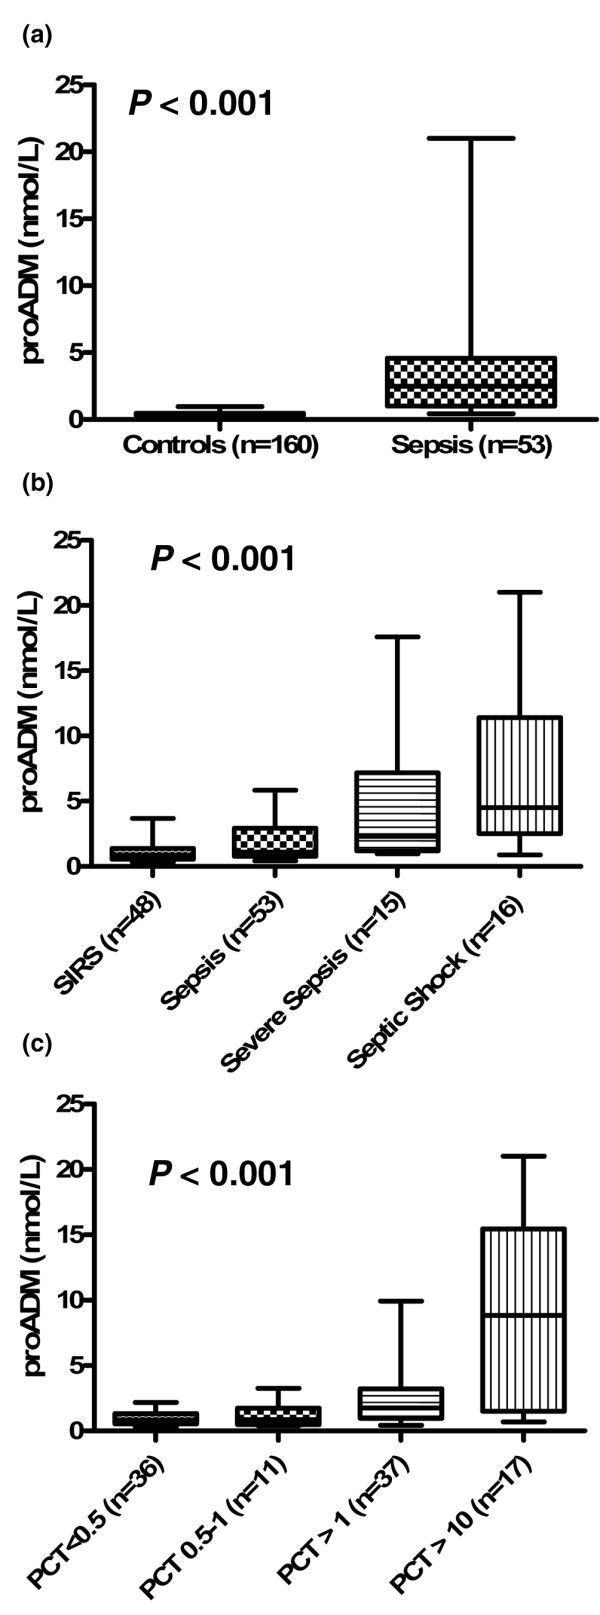
Admission levels of MR-proADM. (a) MR-proADM in patients with sepsis versus healthy control individuals. (b) MR-proADM in patients without infection (for example SIRS), and in patients with sepsis, severe sepsis and septic shock. (c) MR-proADM grouped according to PCT values. Lines denote median values, boxes represent 25–75th percentiles and whiskers indicate the range. The numbers of samples are indicated in parentheses. MR-proADM, mid-regional pro-adrenomedullin; PCT, procalcitonin; SIRS, systemic inflammatory response syndrome.